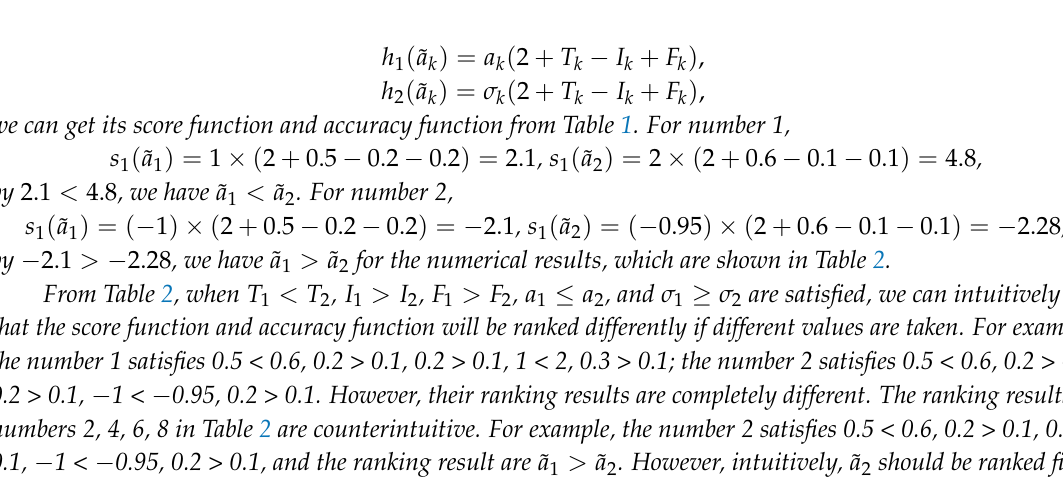
Table 1. The numerical example.